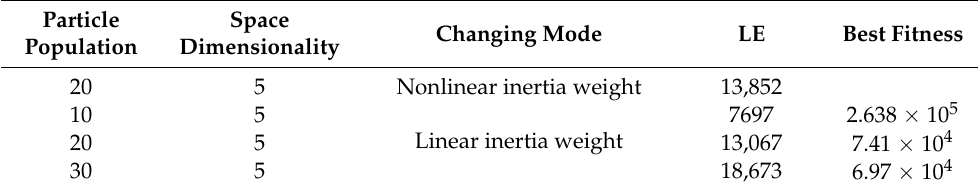
Table 1. FPGA resource occupation under different inertia weight methods and particle numbers.